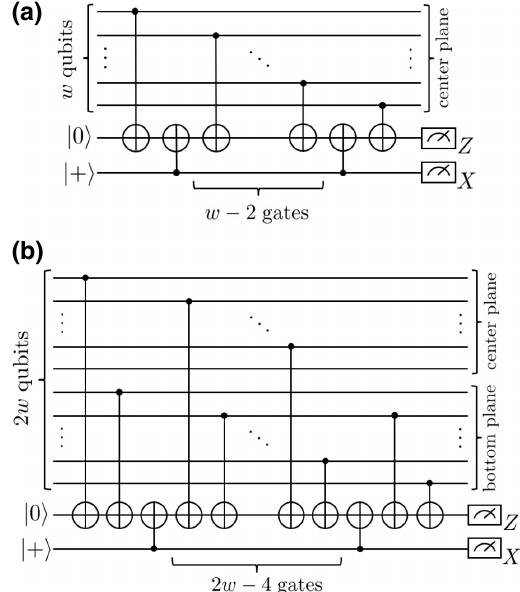
FIG. 13. (a) A flag circuit with one flag ancilla for measuring an f or a cap generator of weight w . (b) A flag circuit with one flag ancilla for measuring a v generator of weight 2 w